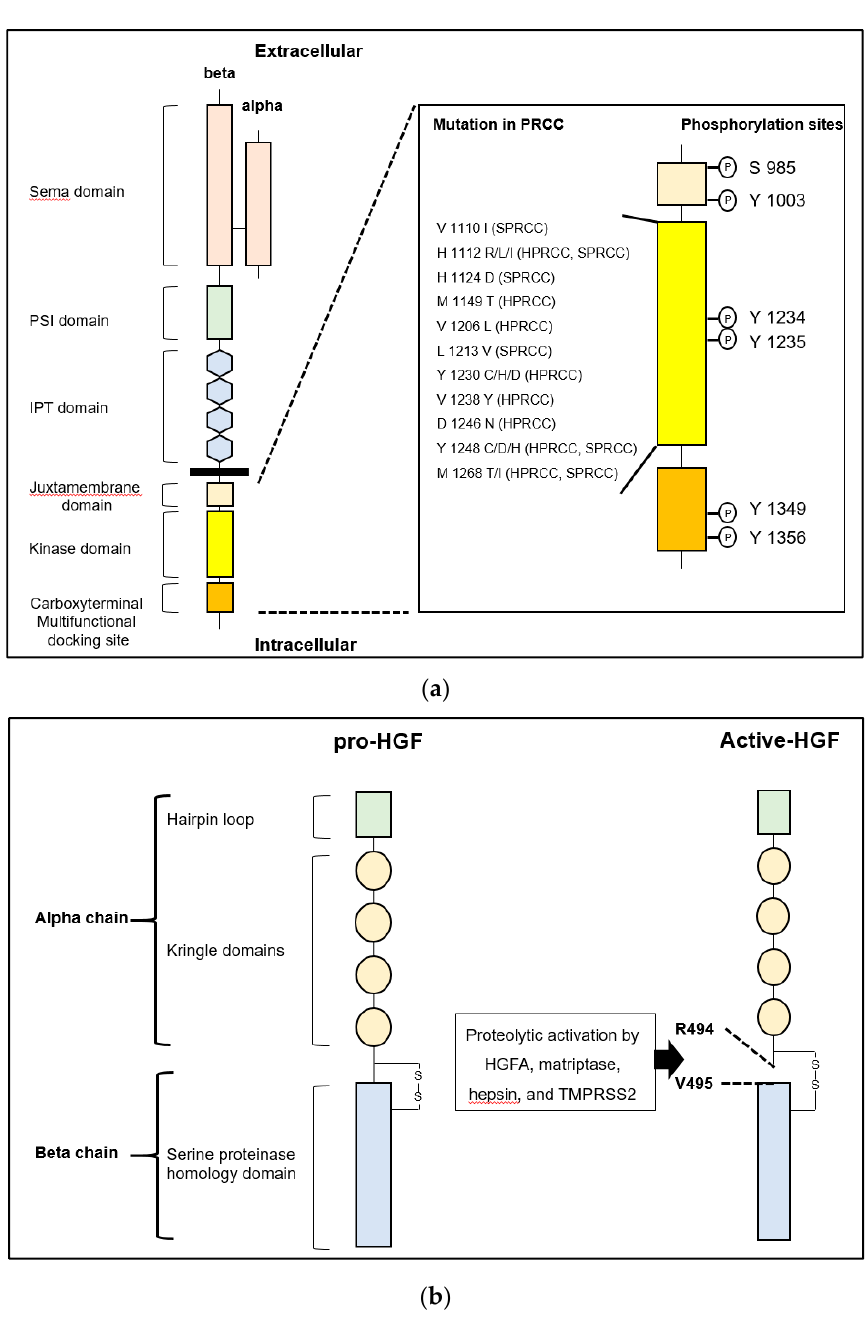
Figure 1. ( a ) Left: The structure of human MET is shown. MET consists of extracellular alpha and single-pass transmembrane beta chain, which are disulfide-linked heterodimer. The beta chain is composed of six major domains including Sema (semaphorin), PSI (plexin, semaphorin, integrin), IPT (immunoglobulin-like regions in plexins and transcription factors), juxtamembrane, tyrosine kinase domain, and multifunctional docking site. Right: Sites of point mutation in hereditary and sporadic papillary renal cell carcinoma (HPRCC and SPRCC) and conventional phosphorylation sites in intracellular domains are shown. ( b ) Left: The structure of human pro-hepatocyte growth factor (HGF) is shown. HGF consists of four Kringle domains and a serine proteinase homology domain. Right: The active form of HGF is shown. HGFA, hepsin, matriptase, and TMPRSS2 proteolytically cleave between Arg 494 and Val 495 to convert to a two-chain heterodimeric active form. One-letter abbreviation of amino acids is used.